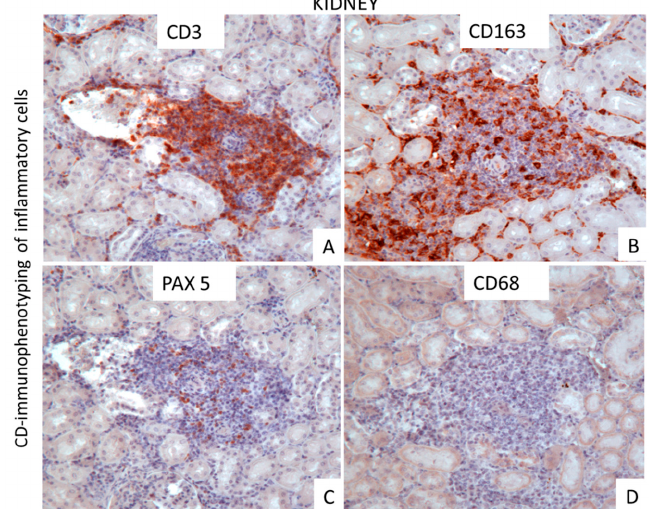
Figure 2. Immunohistochemistry. Kidney ( A – D ). CD immune-phenotyping in non-suppurative interstitial nephritis, revealing intense CD3+ T positive ( A ) cells and CD163+ macrophages ( B ), few PAX 5+ B cells ( C ), and no CD68+ macrophages ( D ). 3-30-diaminobenzidine (DAB) chromogen was used to visualize immune reactions. Mayer’s hematoxylin counterstain, 20× objective.